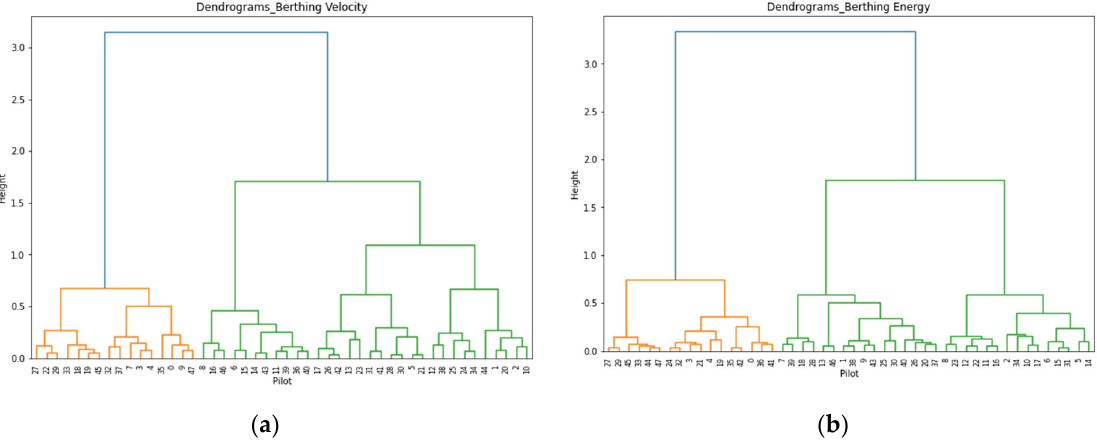
Figure 10. Results of agglomerative clustering: ( a , b ) dendrograms of berthing velocity and energy, respectively.